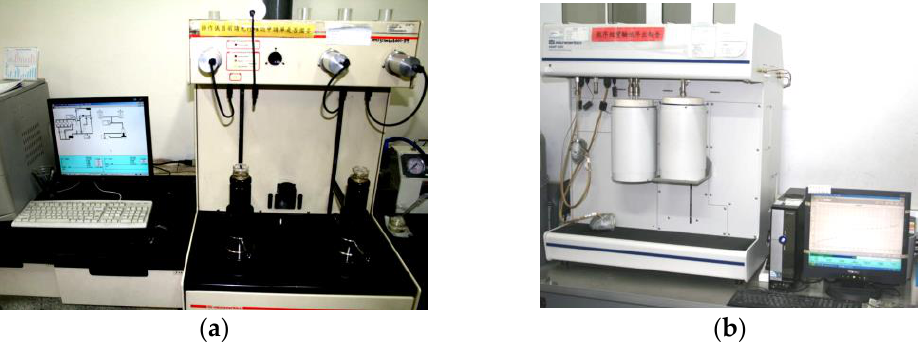
Figure 2. ( a ) Micromeritics AutoPore IV 9520 and ( b ) Micromeritics ASAP 2020 BET Analyzer for pore size and specific surface area measurements.